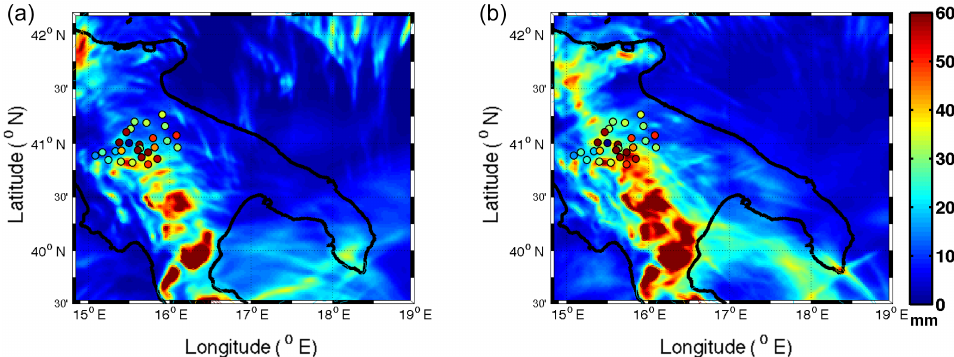
Figure 8. Comparison of 24h cumulated precipitation on 18 February 2011 as modelled by WRF with start time 14h before the rain peak (a) and 38h before the rain peak (b) . Recorded values by 27 gauge stations are